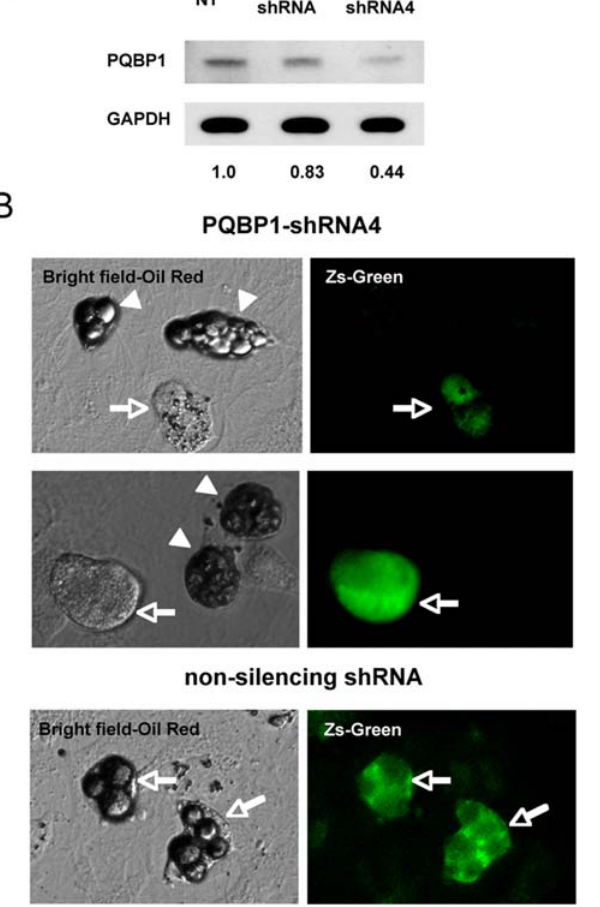
Figure 8. ShRNA-mediated suppression of PQBP1 inhibits lipid storage in white adipocytes. A) Western blot shows that PQBP1- shRNA-IRES-ZsGreen plasmid suppresses PQBP1 protein in primary mouse white adipocytes. Non-silencing shRNA (ns-ShRNA) was used as a control. The band intensities are corrected with GAPDH and standardized with non-transfected cells (NT). B) Primary white adipocytes were stained by Oil Red after transfection with PQBP1- shRNA-ZsGreen or non-silencing shRNA-ZsGreen plasmid. Non-trans- fected cells (arrowheads) possess large lipid droplets while PQBP1- shRNA-transfected cells (green) show small granules (arrows). Non- silencing shRNA-transfection did not affect the size of lipid granules (arrows in lower